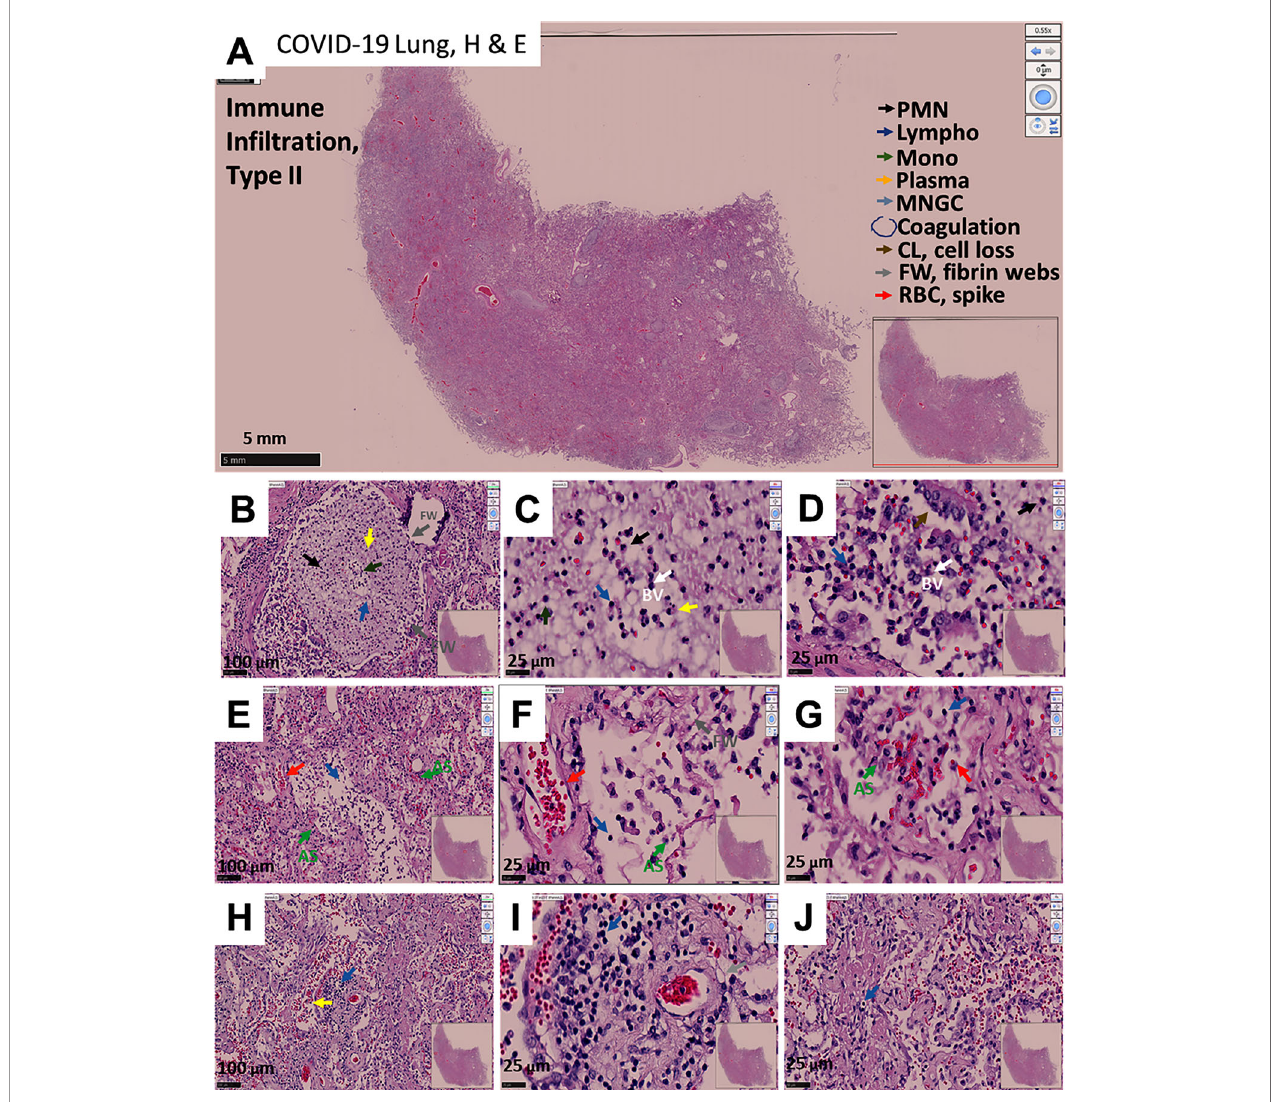
FIGURE 2 | Representative microphotograph of eight serial sections of lung obtained from a deadly case of COVID-19, with immune in fi ltration without hemorrhagic events. (A) Representative H&E-stained lung classi fi ed images as immune in fi ltration. Low magni fi cation allows us to appreciate the degree of damage, fi brosis, and intravascular coagulation webs trapping immune cells within the blood vessels. Bar: 5 mm. (B – D) Correspond to higher magni fi cation to denote the intravascular clots and webs. Bar 100 µm and 25 µm. (E – G) Correspond to fi brotic alveolar areas. Bar 100 µm and 25 µm. (H – J) represent fi brotic alveolar areas with signi fi cant immune in fi ltration. Note the fi brosis and formation of intravascular fi brin webs. As indicated in A, arrows of different colors indicate representative cell types, areas with coagulation, cell loss (CL), Fibrin webs (FW), and red blood cells with spikes (RBCs). n = 4 different individuals with 15-20 serial